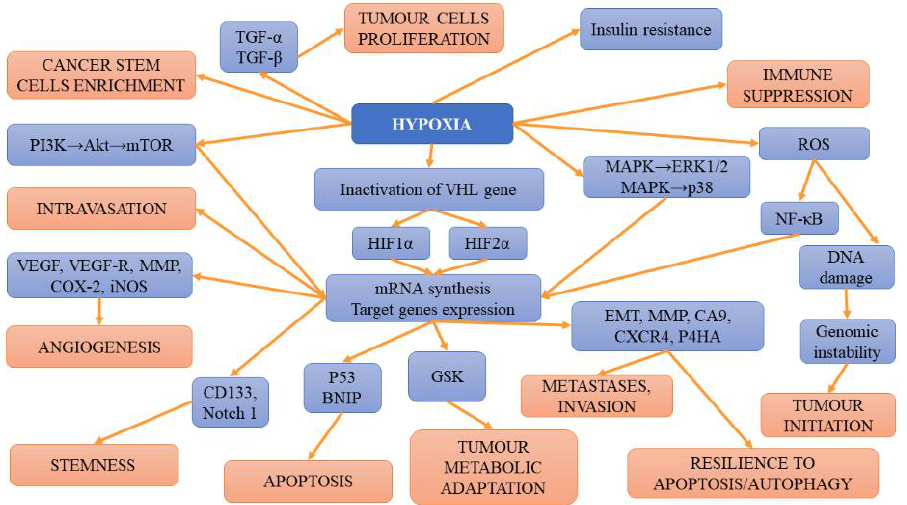
Figure 1. The summary of hypoxia-related mechanisms involved in tumour initiation, progression and metastases .